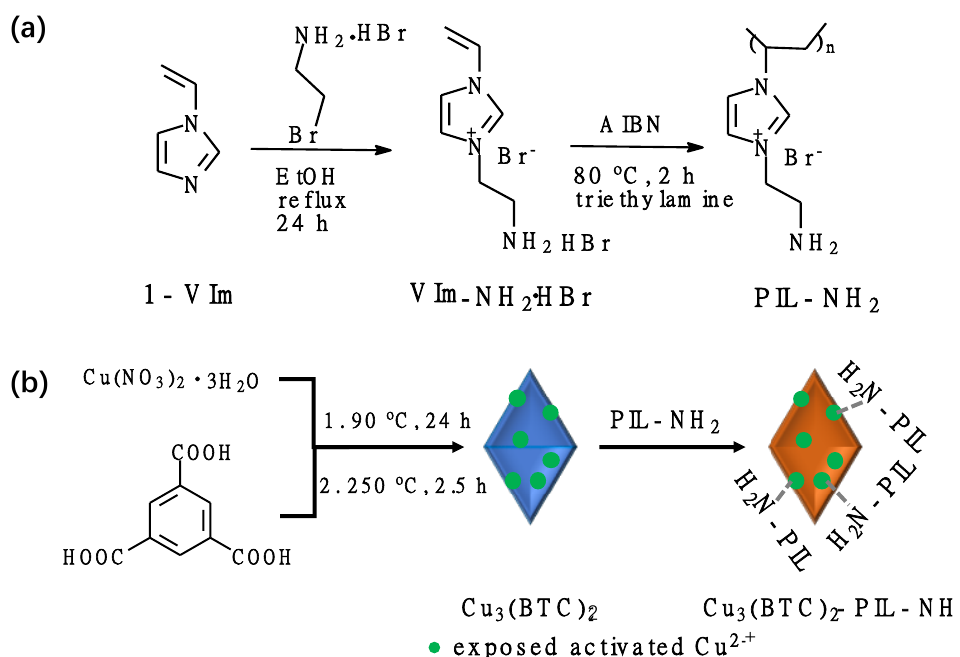
Figure 1. ( a ) Synthesis of amine-functionalized imidazolium-type poly(ionic liquid). ( b ) Schematic illustration of the synthetic process of composite sorbent of Cu 3 (BTC) 2 and poly(ionic liquid).